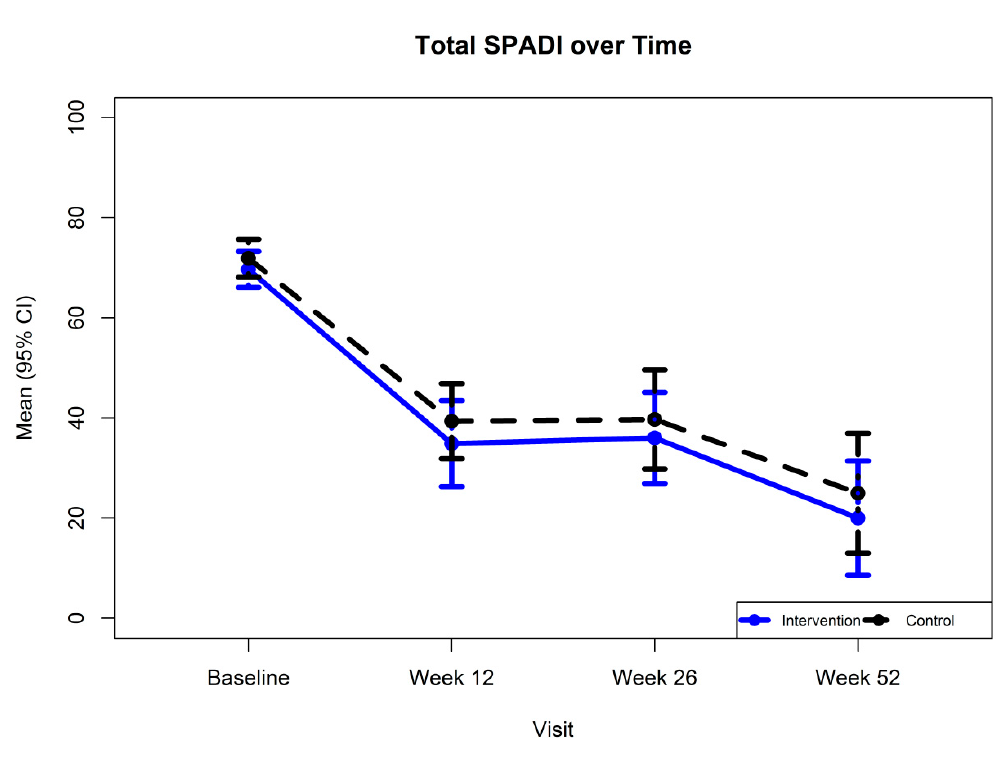
Figure 2. Mean (95% CI) for SPADI Total Score over time. (Intervention—Baseline n = 68, Week 12 n = 50, Week 26 n = 35, Week 52 n = 20; Control—Baseline n = 68, Week 12 n = 54, Week 26 n = 37, Week 52 n = 22).